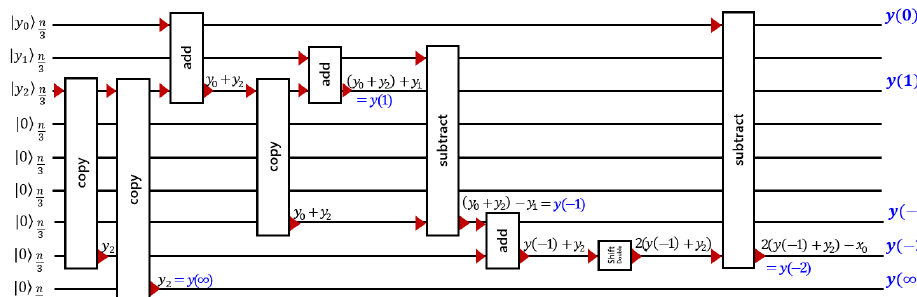
Figure 3. Quantum Circuit for Evaluation of Point X.